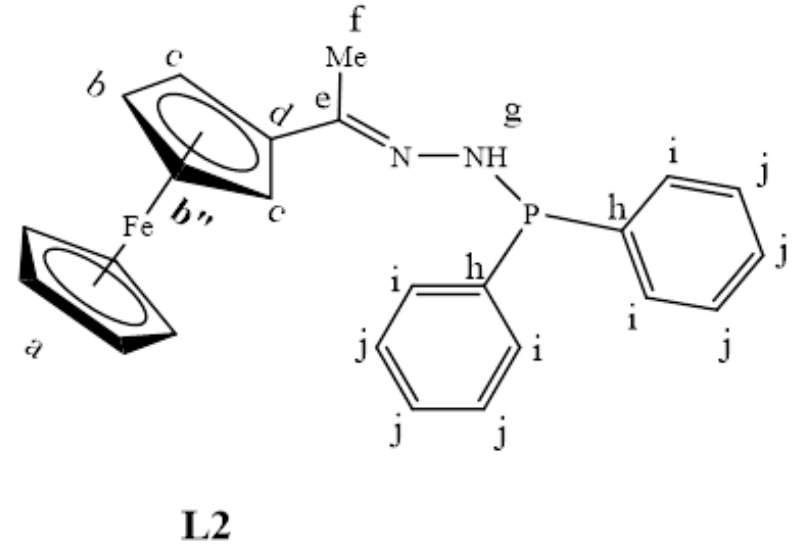
Figure 24. The chemical structure of L2 . 3.2.3. Preparation of Ferrocenyl(Diphenylphosphine)Phenylimine Ligand, L3 L1 (0.834 g, 0.00344 mmol) was dissolved in dry EtOH (30 mL) and 2-diphenylphosphine benzaldehyde (1.00 g, 0.00344 mmol) was added. The solution was refluxed at 85 o C for 24 h to achieve a Schiff base condensation reaction. The solvent was then removed using a rotary evaporator and a red precipitate of L3 (Figure 25) was obtained. This was then dried under vacuum for 5 h. Yield: 0.00156 g, 88%. Melting point: 62–64 ◦ C. FT-IR ( ν max /cm − 1 ): 1555 (C=N) and 1607 (C=N). 1 H-NMR (DMSO- d 6 ): δ ppm = 2.16 (s, 3H, H m ), 4.13 (s,